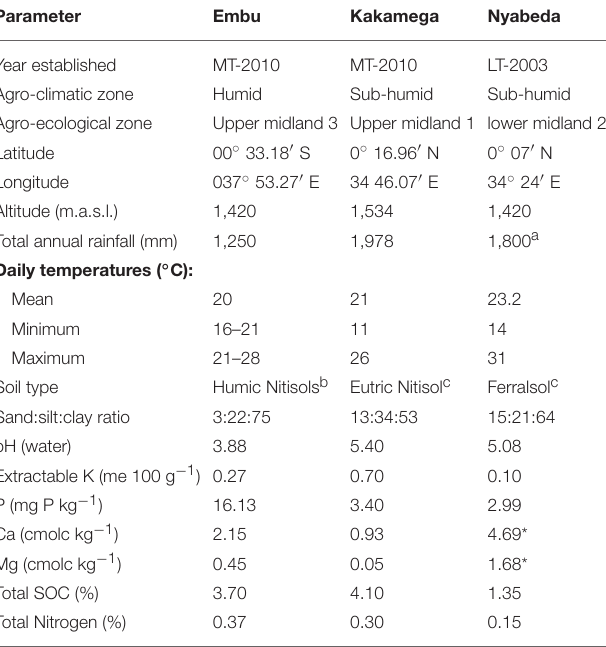
TABLE 1 | Location, climatic, and soil characteristics of the study sites.